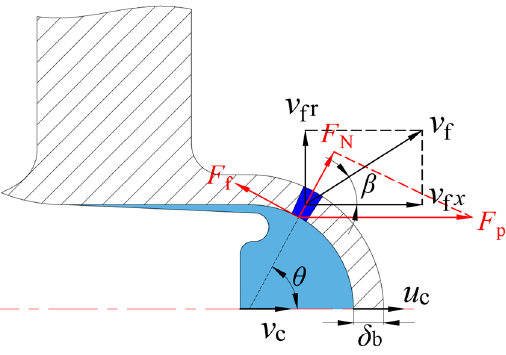
Figure 17. Schematic diagram of force and dispersion of BAD.